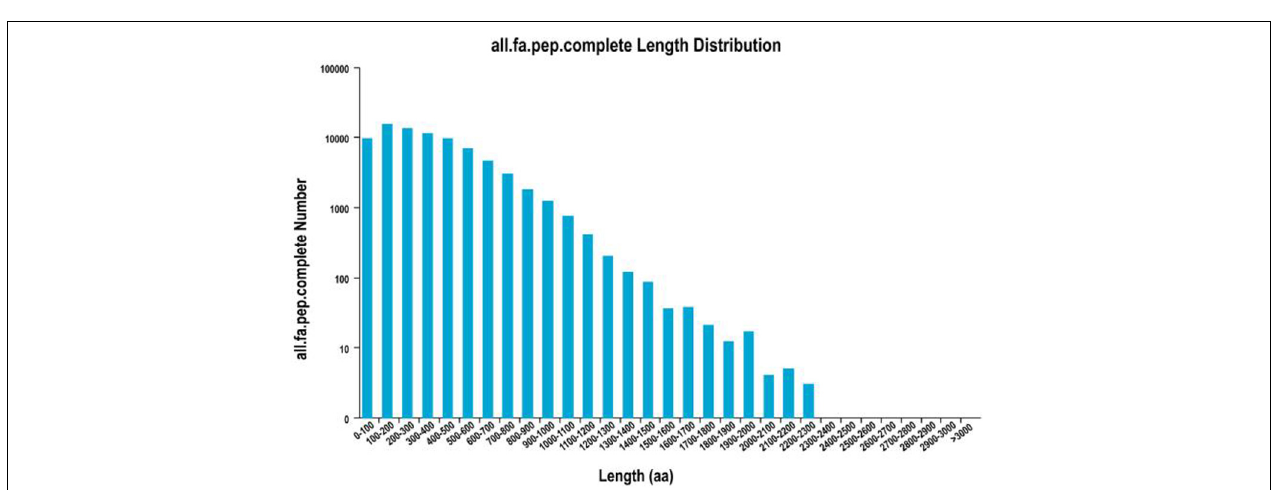
FIGURE 1 | Length distribution of full-length non-chimeric sequence.